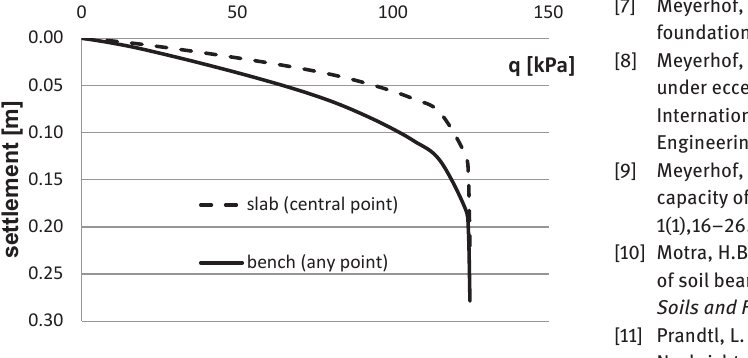
Figure 13: Example of load—settlement curves for bench and central point of the slab—results of the 3D